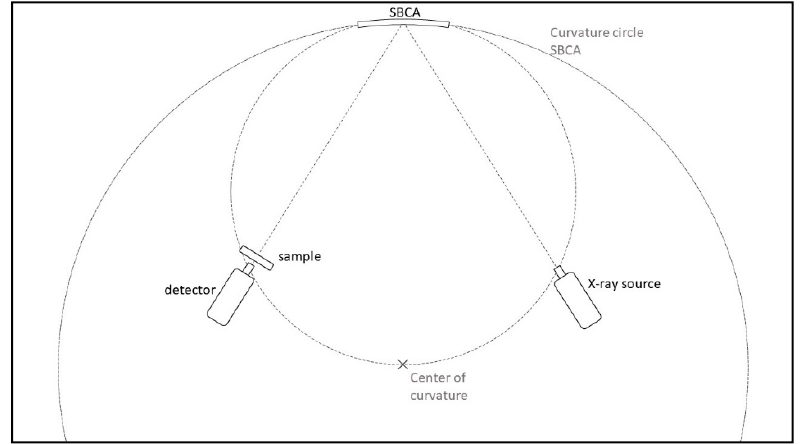
Figure 3. Scheme of the Rowland circle monochromator. The outer circle represents the curvature of the SBCA. The inner circle has a diameter matching the radius of the curvature circle. On this inner circle, the X-ray source and the detector are positioned. The sample is positioned right in front of the detector. The components are set on a scissor drive, allowing fine energy scanning.